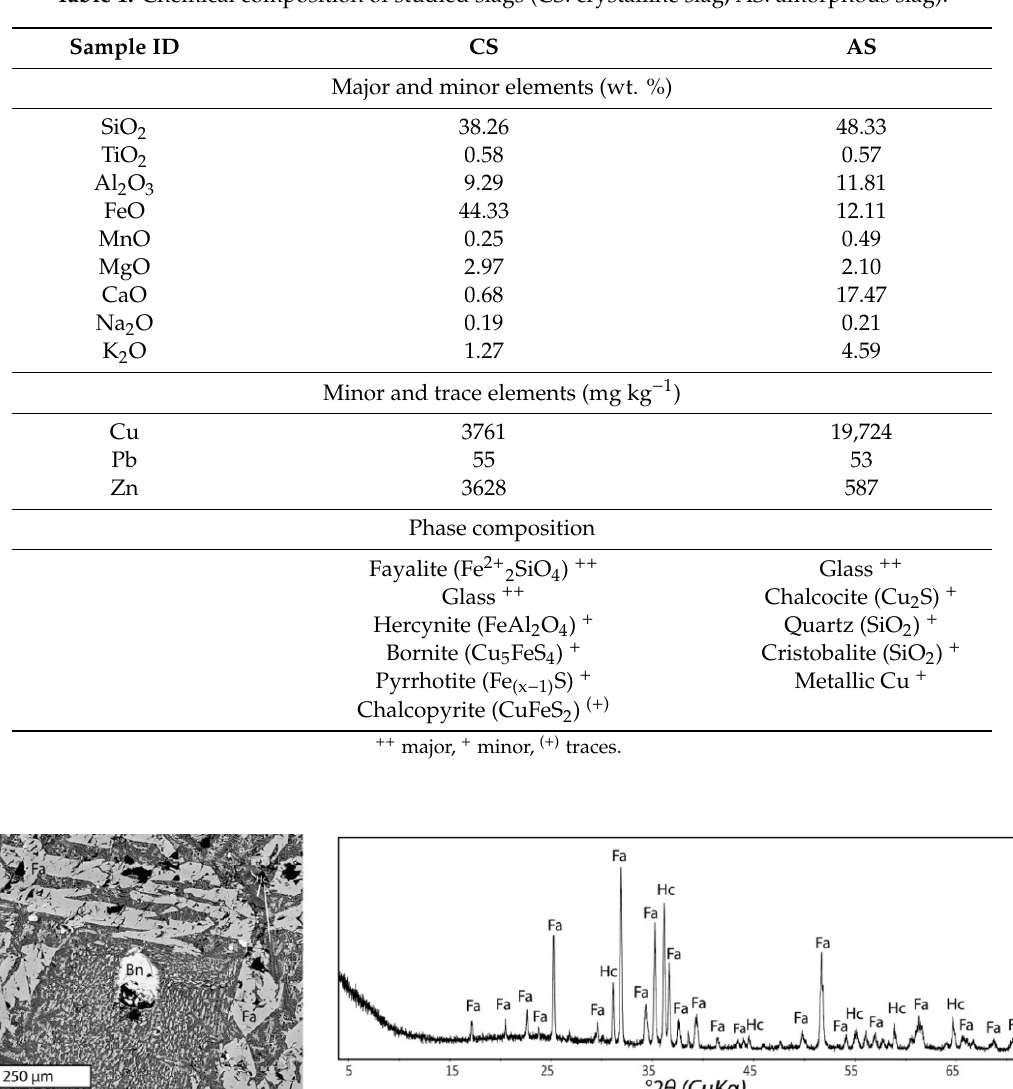
Table 1. Chemical composition of studied slags (CS: crystalline slag, AS: amorphous slag).